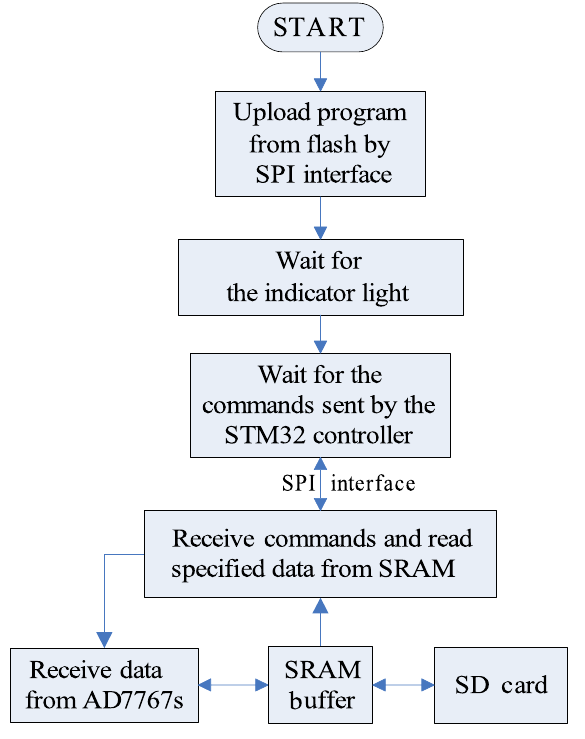
Figure 10. Flowchart of system program.